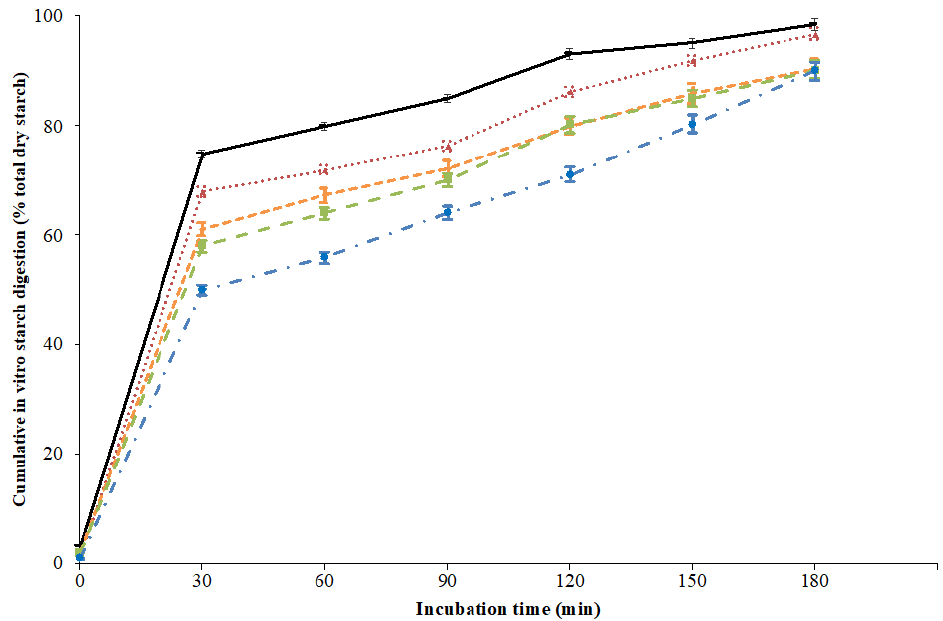
Figure 1. In vitro starch digestion curves of gluten-free macaroni containing resistant starch from annealed white sorghum starch (annRS). Control: gluten-free macaroni prepared with 100% w / w rice flour (red line); 5-annRS: gluten-free macaroni prepared by mixing rice flour and annRS 95:5 w / w (orange line); 10-annRS: gluten-free macaroni prepared by mixing rice flour and annRS 90:10 w / w (green line); 15-annRS: gluten-free macaroni prepared by mixing rice flour and annRS 85:15 w / w (blue line). White wheat bread is used as a reference (black line). Before analyses, pasta samples were cooked to optimal cooking time.